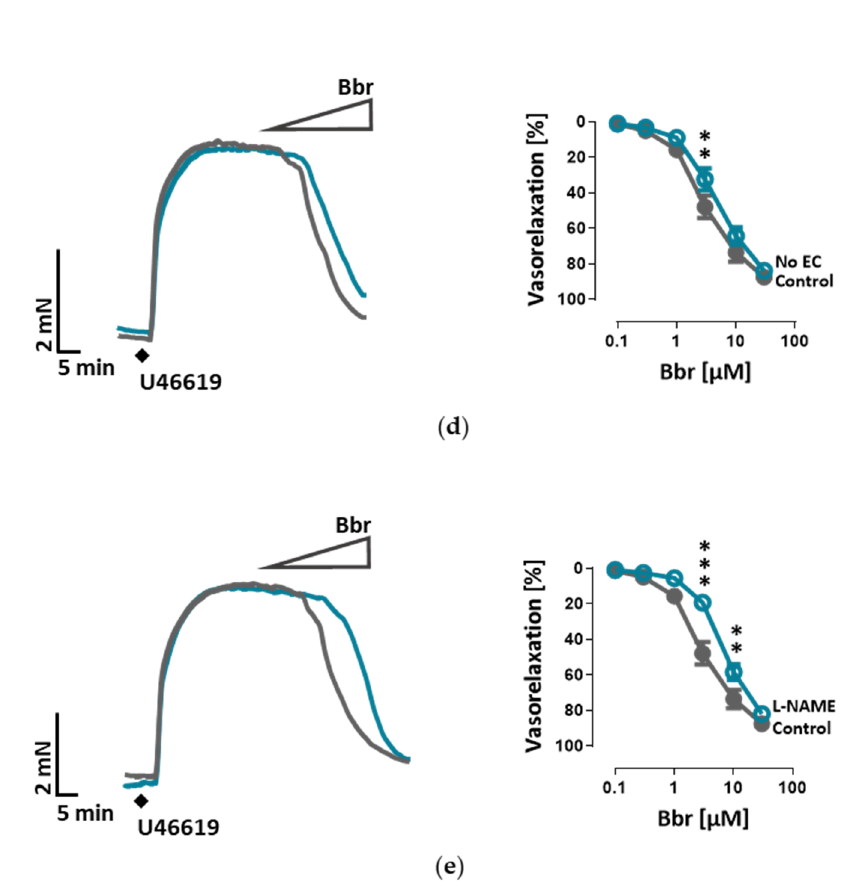
Figure 1. TMEM16A defines calcium-activated chloride current in pulmonary arterial endothelial cells (PAECs). ( a ) Western blot showing TMEM16A expression in donor PAECs, pulmonary arterial smooth muscle cells (PASMCs) and human lung homogenate (hLH) (N = 2–3 patients). Vinculin served as loading control. ( b ) Representative whole-cell, Ca 2+ -activated Cl − current (I ClCa ) traces (left) and normalized current-voltage (I-V) relationships measured with voltage clamp in PAECs showing the effect of benzbromarone (Bbr) (right). ( c ) Calculated Bbr-sensitive current in donor PAECs and PASMCs. Figures were generated with n = 5–13 cells from healthy donors. ( d – e ) Representative isometric tension measurements and quantification showing endothelial contribution of Bbr effectiveness on U46619 pre-constricted mouse pulmonary arteries with either endothelium removed (no EC; d) or incubation with 300 μm L-NAME ( e ) ( n = 4–7). ** p < 0.01, *** p < 0.001, ANOVA with Bonferroni post-hoc test, data are presented as mean ± s.e.m.